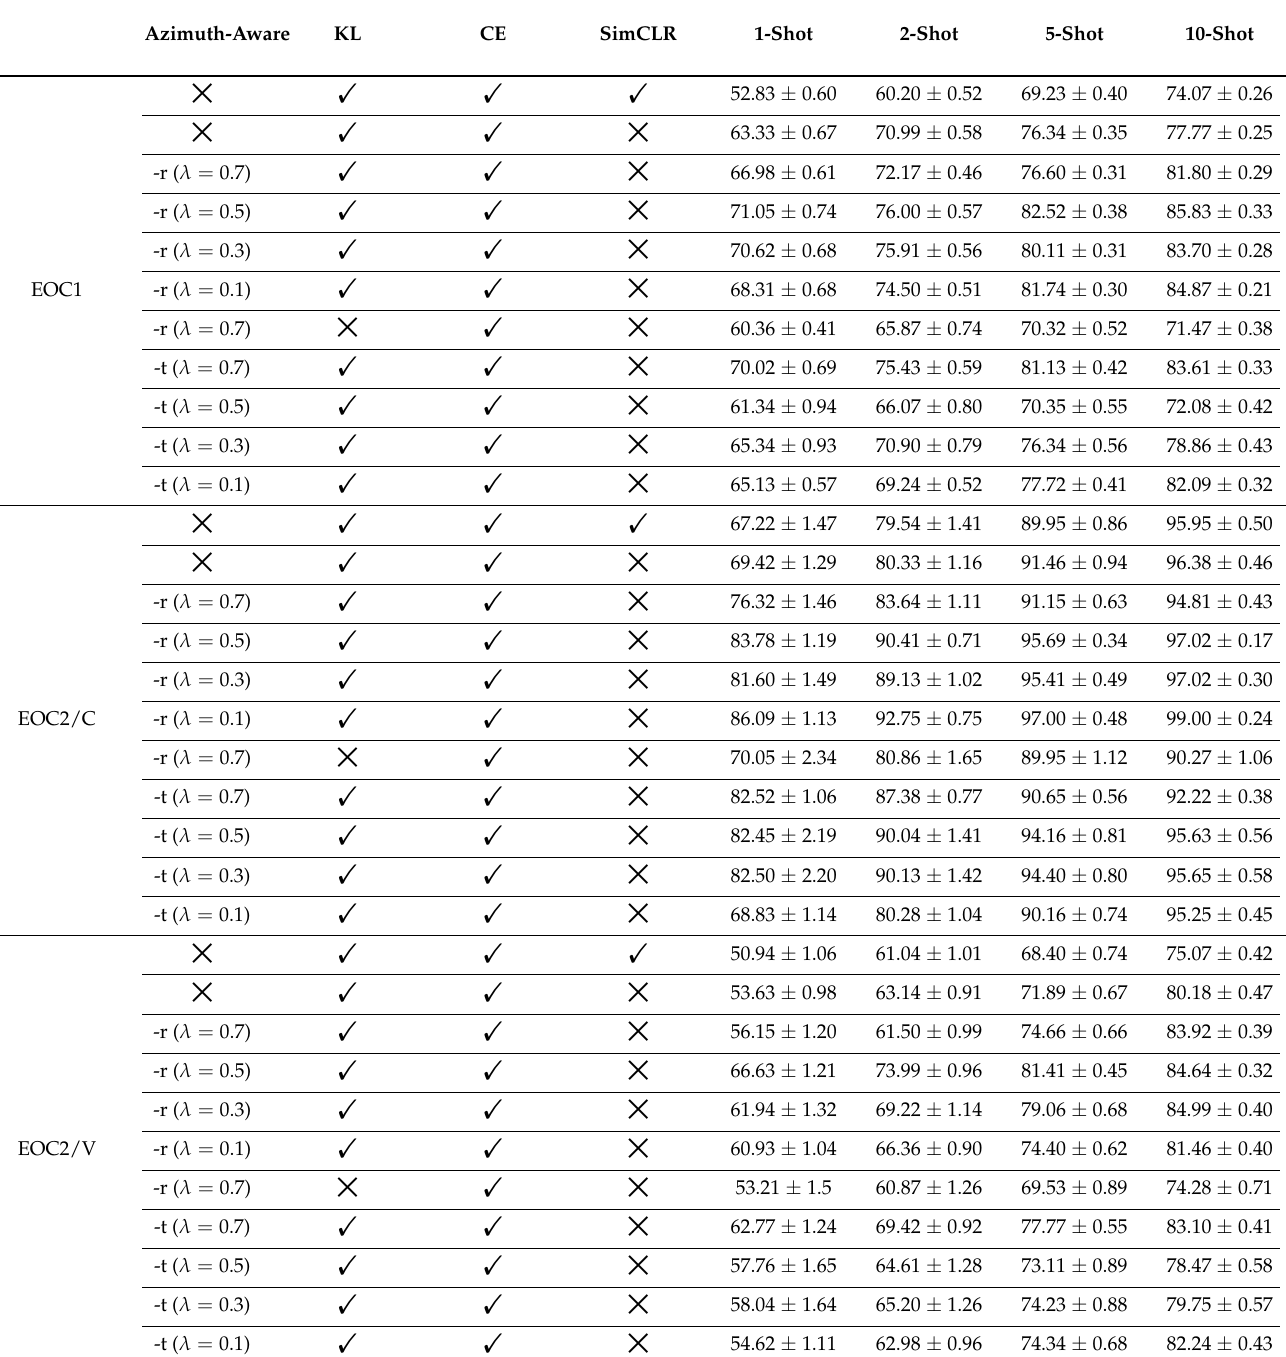
Table 6. Influence of different loss module among EOCs